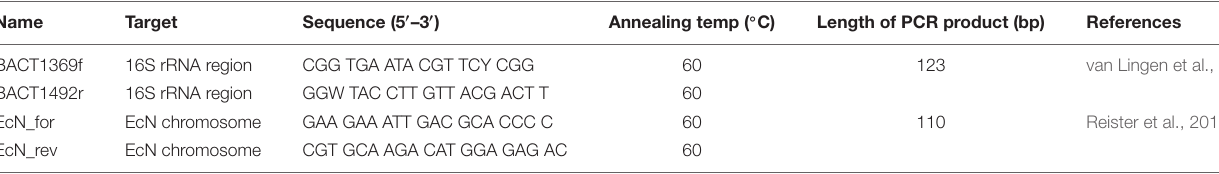
TABLE 1 | Primers used for the quantification of EcN.